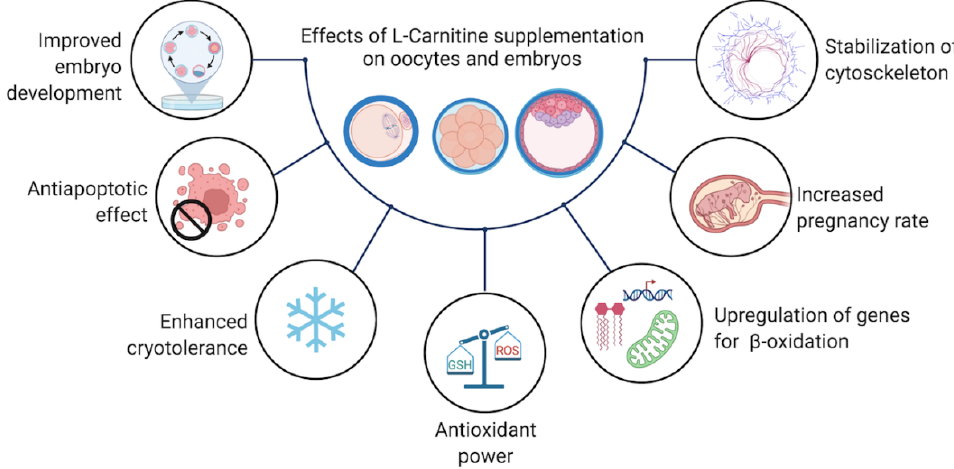
Figure 3. Effects of L -carnitine supplementation in media for oocyte and embryo culture. Effects on Beta-Oxidation